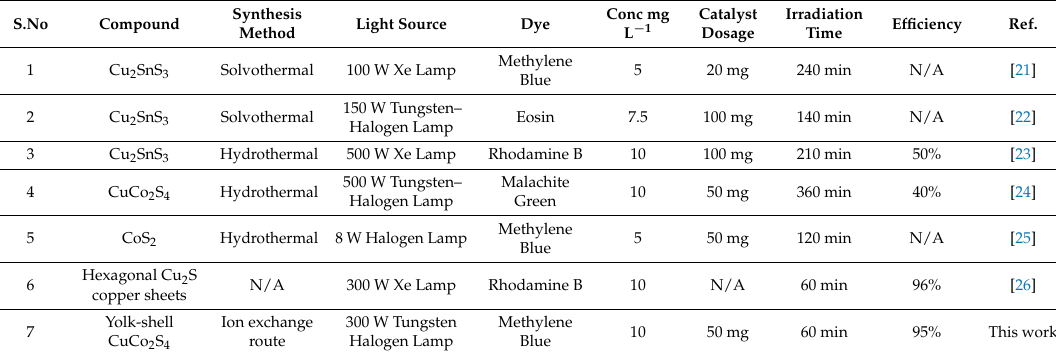
Figure 6. Cycle runs of MB photocatalytic degradation in the presence of crystalline CuCo 2 S 4 . Table 1. Summary of photocatalytic performance of copper based photocatalyst materials.